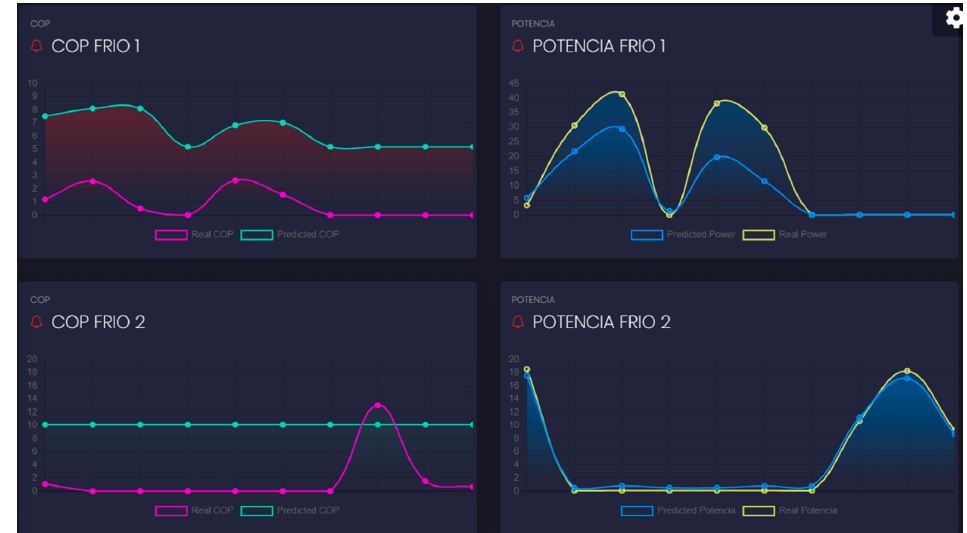
Figure 9. Time–domain evolution of variables ‘COP’ and ‘potency’ for coolers 1 and 2.